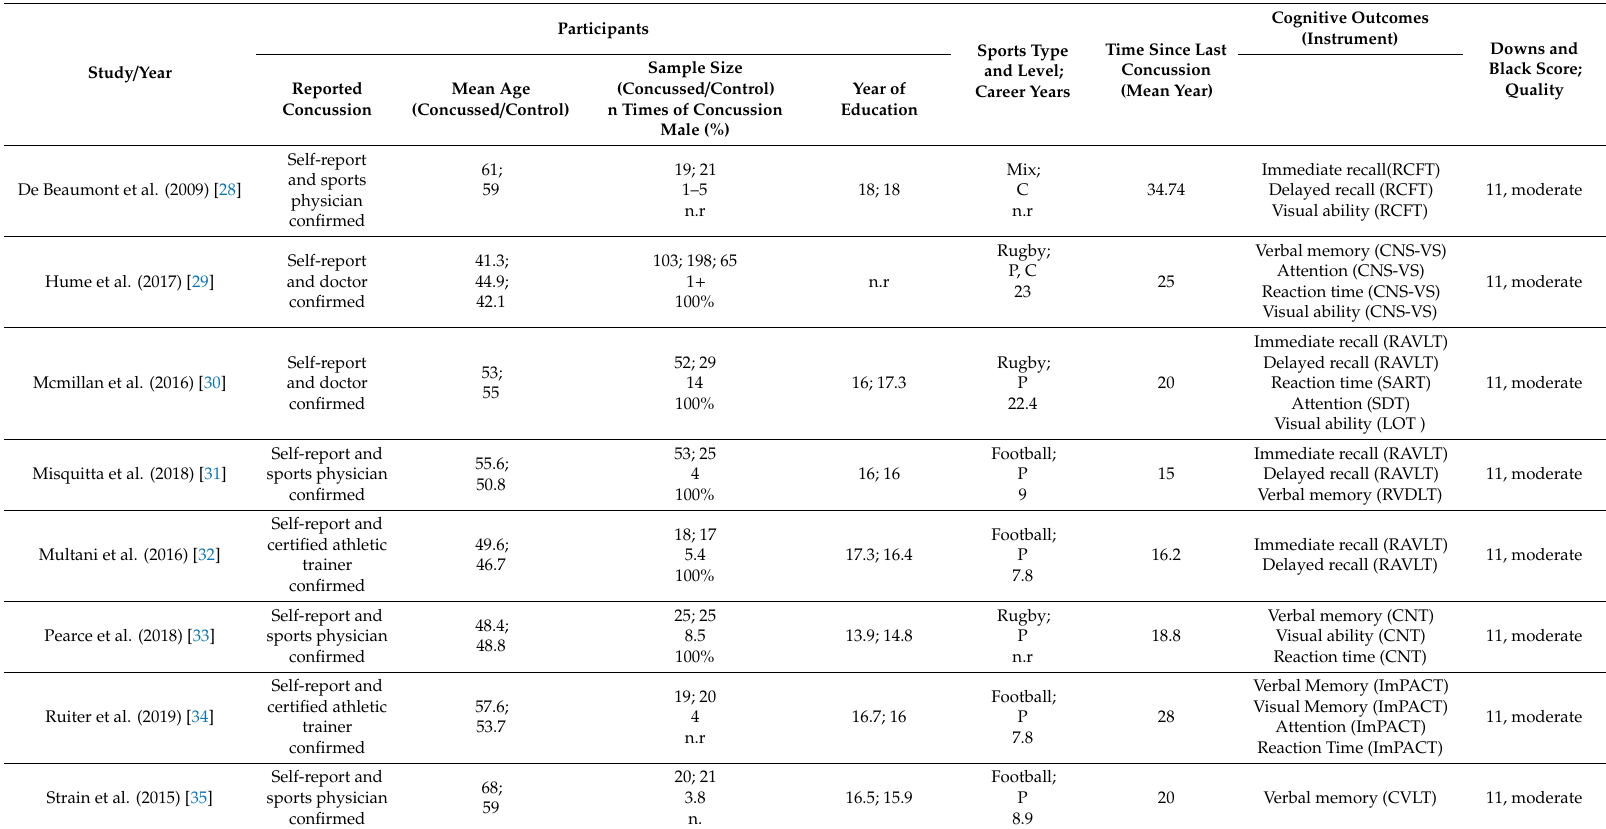
Table 1. Characteristics of randomized controlled trials in the